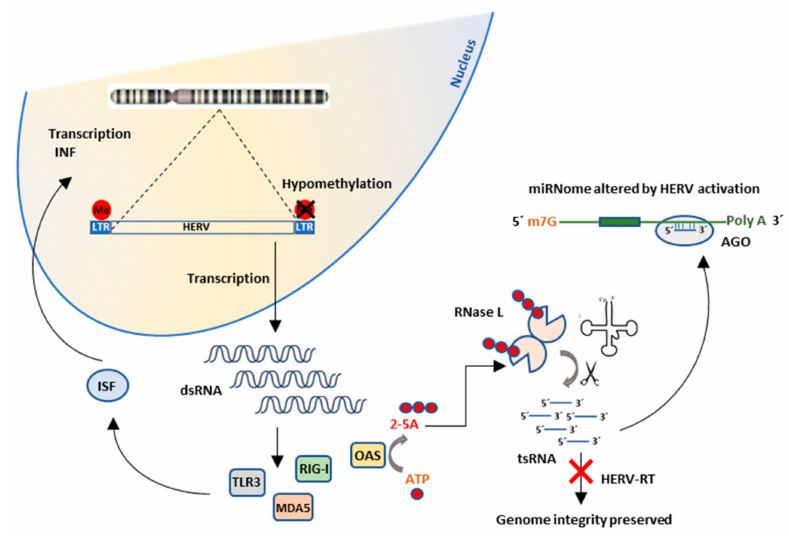
Figure 6. Proposed mechanism linking overexpression of HERVs, INF induction and increased cancer susceptibility in patients with defective ribonuclease activity. ISF (Interferon stimulating factors); TLR3 (Toll-like receptor 3); MDA5 (Melanoma di ff erentiation associated gene 5); RIG-I (Retinoic acid-inducible gene I); OAS (2’-5’-oligoadenylate synthetase); 2-5A (2’, 5’ oligomers of ATP); tsRNAs (transfer RNA small fragments); RT (reverse transcription); AGO